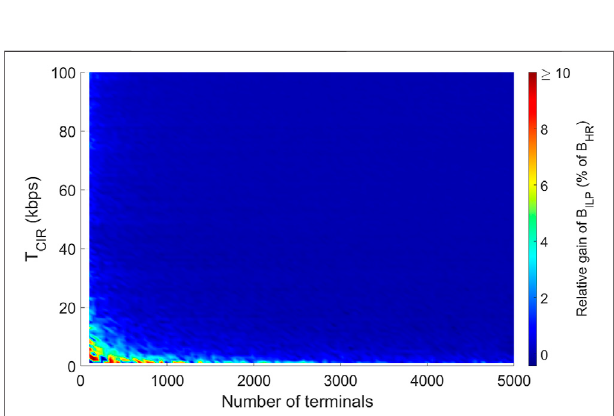
FIGURE 8 | Relative gain of B ILP compared to B HR in function of number of user terminals and T CIR .